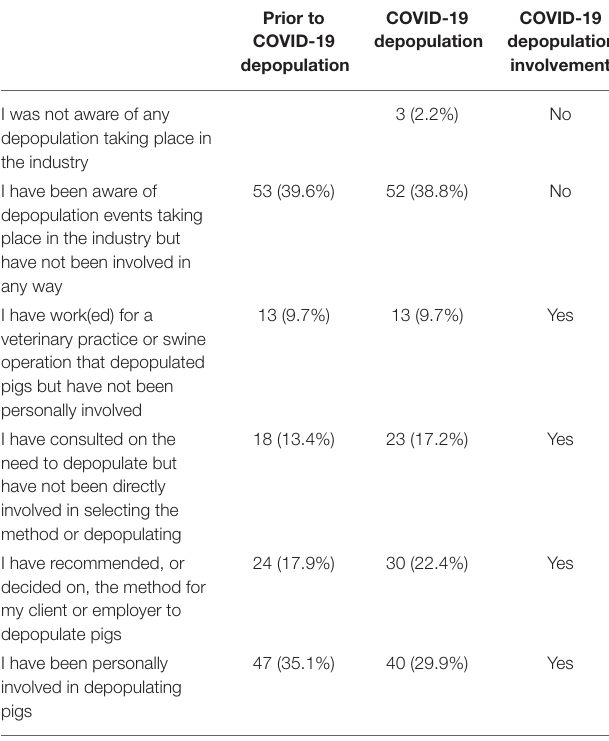
TABLE 12 | Pattern matrix for stress related to depopulation participation by the